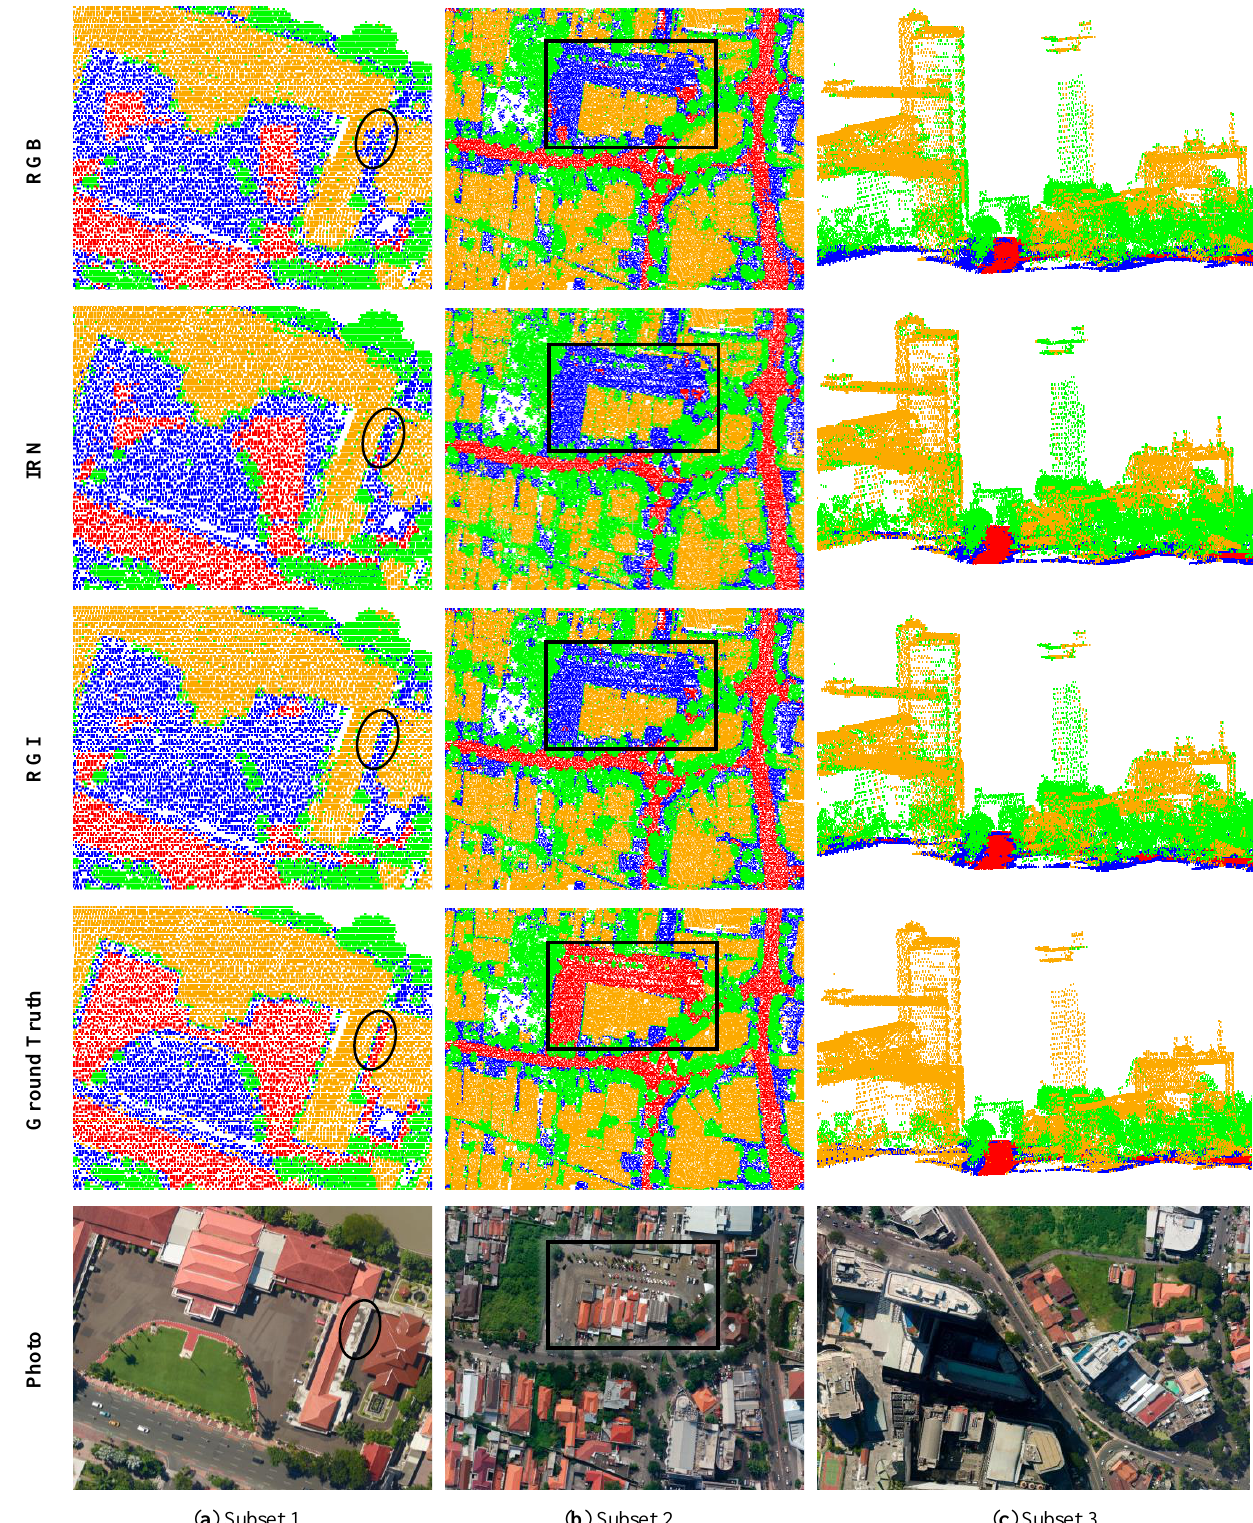
Figure 6. Comparison of DGCNN point cloud semantic segmentation results using different feature combinations (RGB, IRN, RGI) to the reference for three different subset areas. Black ellipses and rectangles highlight the differences in result between three feature combinations and the ground truth. Blue points represent bare-land, orange represents building, green represents vegetation, and red represents